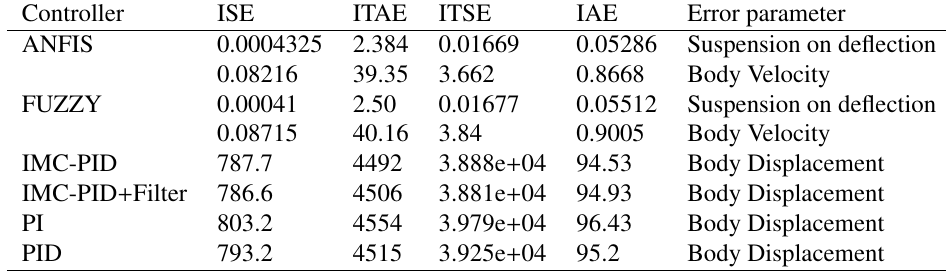
Table 3. Performance